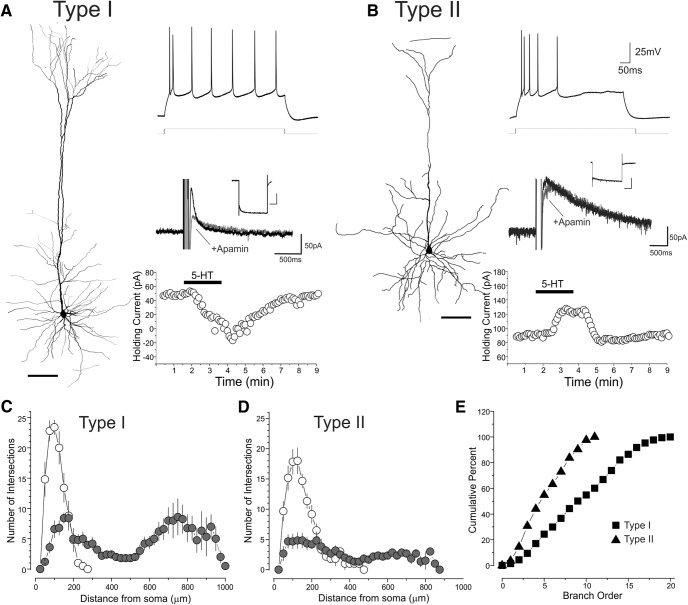
Neuronal morphology of type I and type II neurons. A, Reconstruction of an electrophysiological and pharmacologically identified type I neuron. Neuron reconstruction scale: 100 μm, Ih inset scale, 500 ms, 200 pA. B, Reconstruction of an electrophysiological and pharmacologically identified type II neuron. Neuron reconstruction scale: 100 μm, Ih inset scale, 500 ms, 200 pA. C, D, Scholl plots for the apical (filled circle) and basal (hollow circles) dendrites. Error bars depict the SEM. Branch order cumulative histogram for type I and type II pyramidal cells of L5. Panels C–E depict results derived from 5 type I and 7 type II neurons.